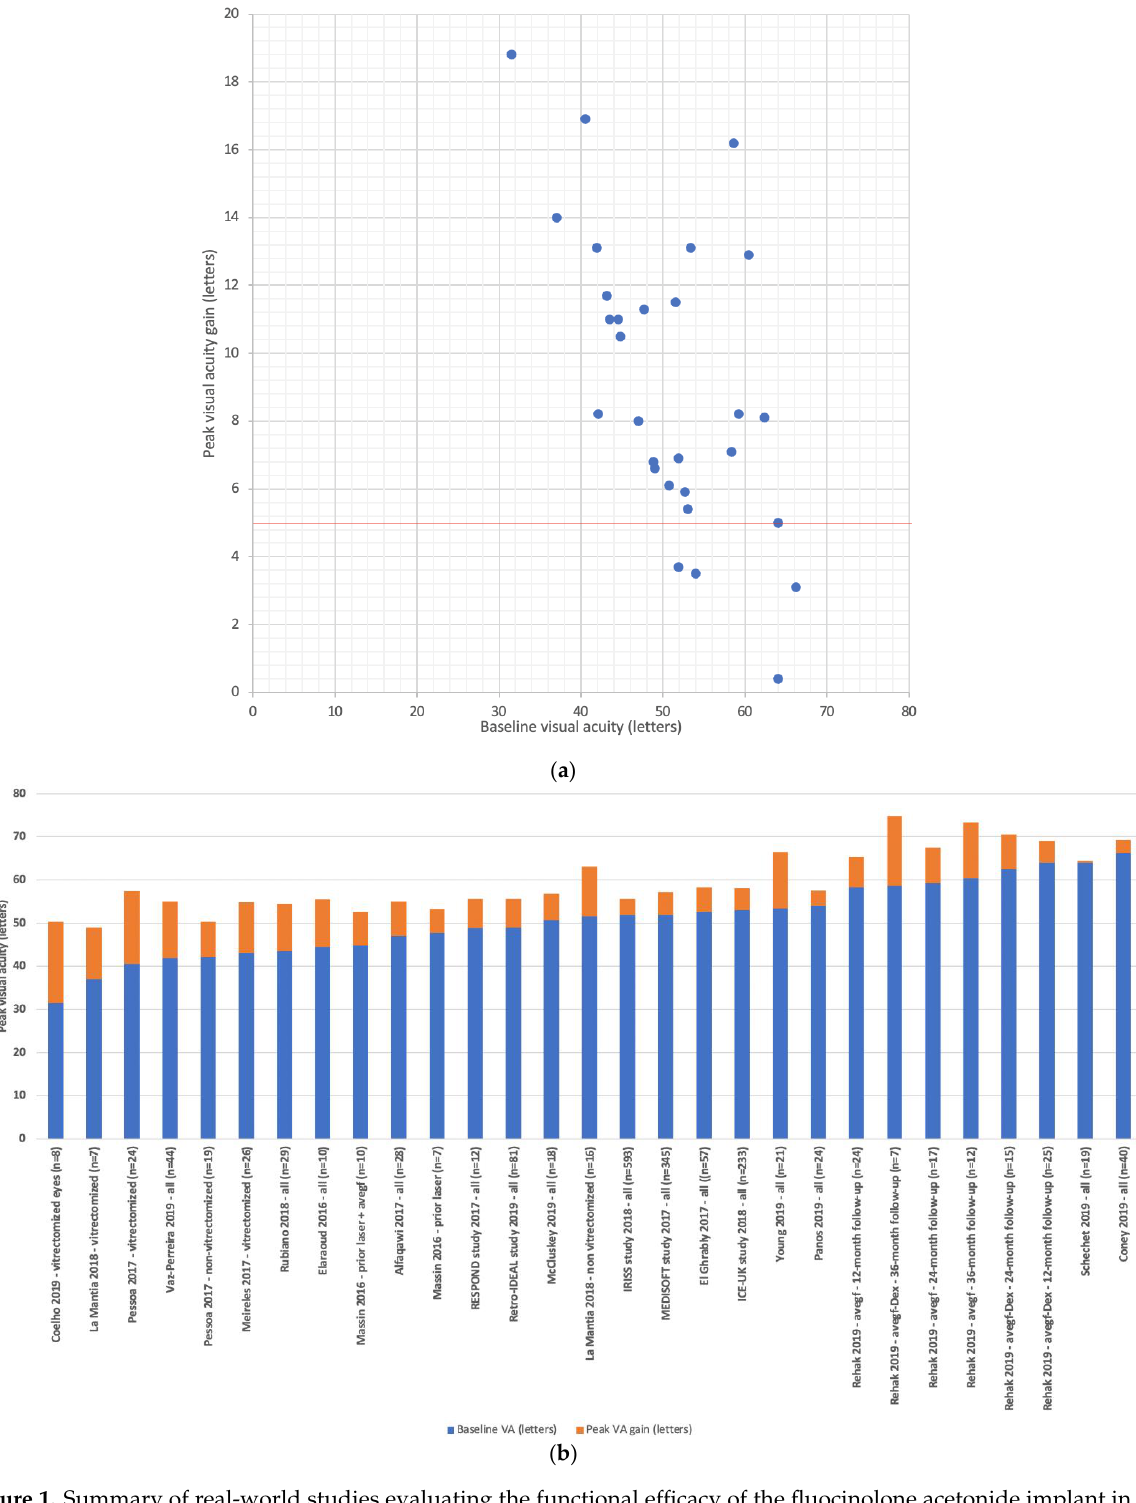
Figure 1. Summary of real-world studies evaluating the functional efficacy of the fluocinolone acetonide implant in the treatment of diabetic macular edema. ( a ) peak visual acuity; ( b ) peak visual acuity gain. Mean follow-up was 20.0 months ( n = 22 studies).